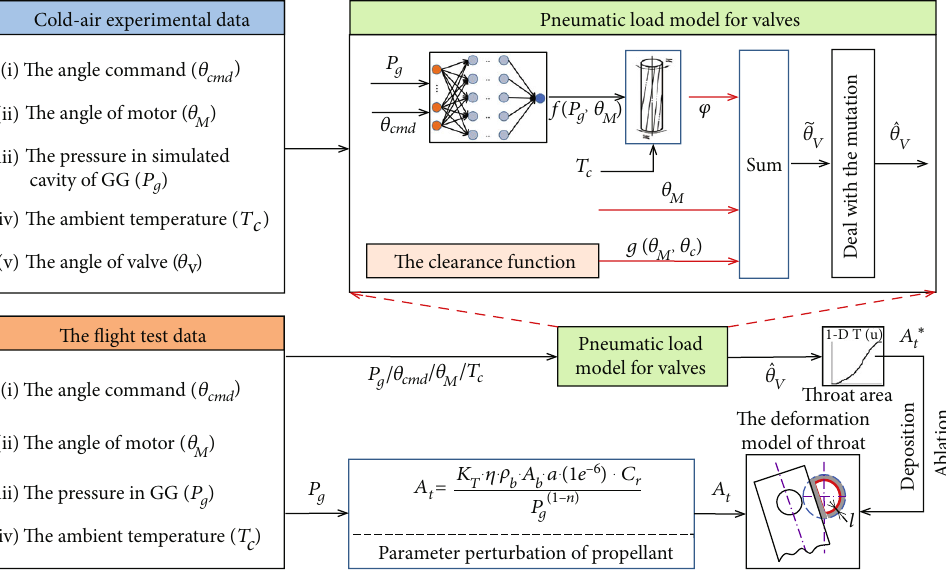
Figure 4: Fundamentals of building valve